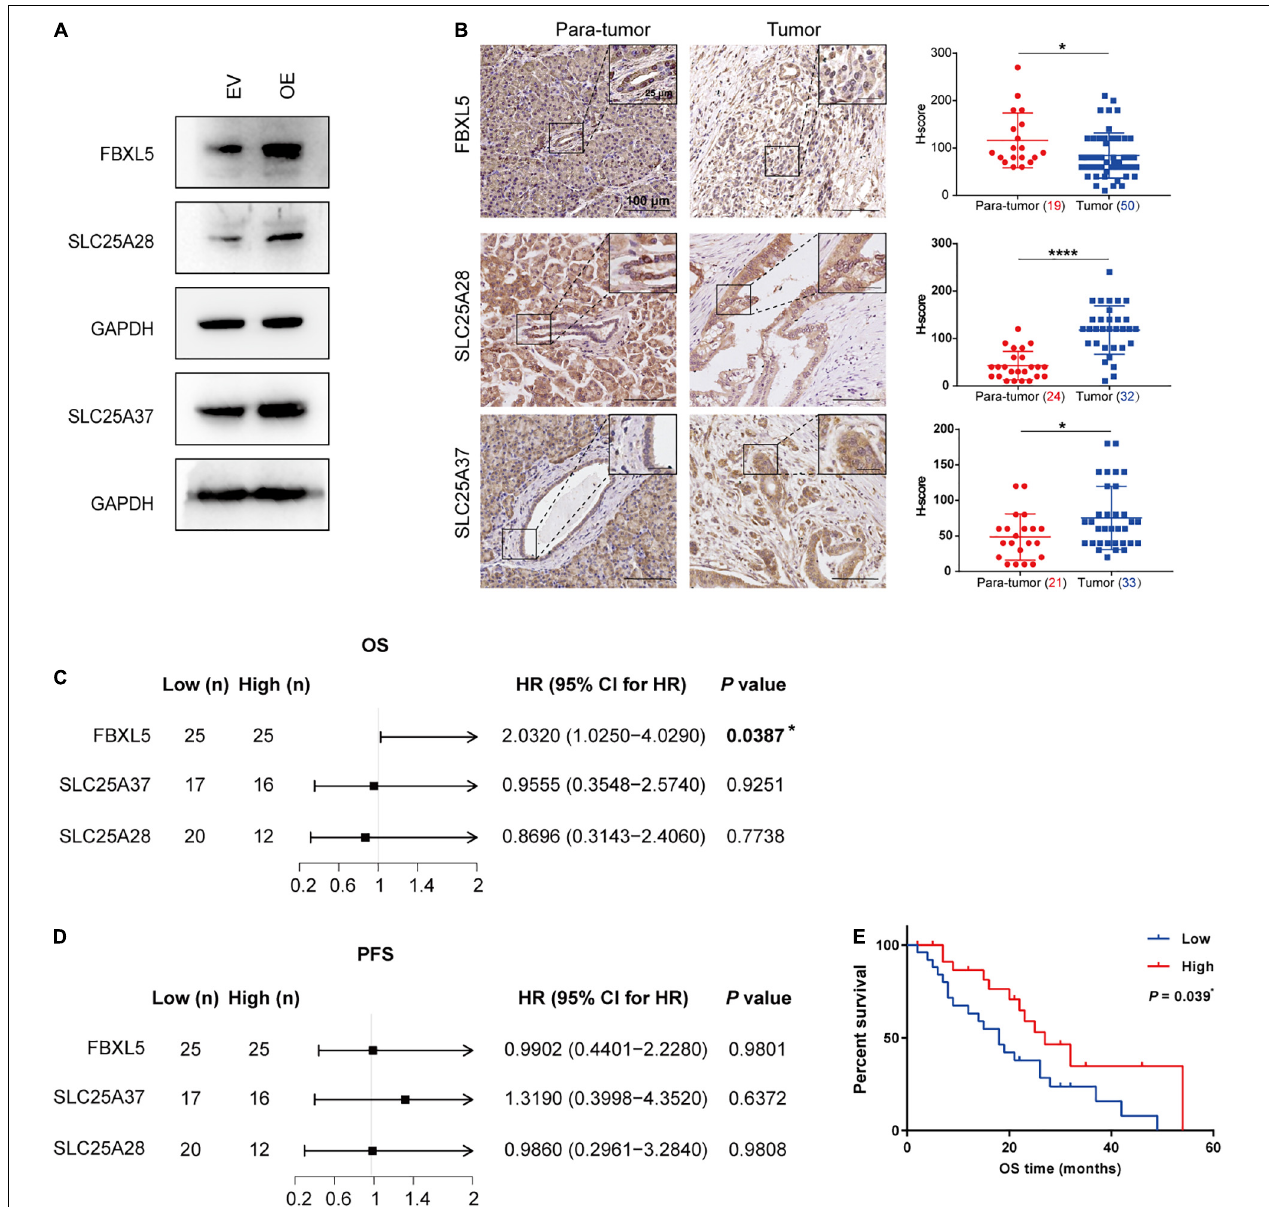
FIGURE 6 | Downregulation of FBXL5 in PDAC predicts poor prognosis. (A) Western blot analysis showing the effect of ALKBH5 overexpression on FBXL5, SLC25A28, and SLC25A37. EV, empty vector; OE, ALKBH5-overexpressing cells. GAPDH is used as an internal control. (B) Representative images of immunohistochemical staining showing the expressions of FBXL5, SLC25A28, and SLC25A37 in para-tumor and tumor cells. Enlarged images in the box are shown in the upper right. Scatter plots showing the H -scores of each gene in para-tumor and tumor cells are shown in the right. Case numbers are shown in brackets. Scale bars, 100 or 25 µ m. (C,D) Log-rank analysis of correlation between overall survival (OS) or progression-free survival (PFS) and the expression of FBXL5, SLC25A28 and SLC 25A37 in tumors. (E) Kaplan–Meier curves for OS of FBXL5 protein expression. * P < 0.05, **** P <